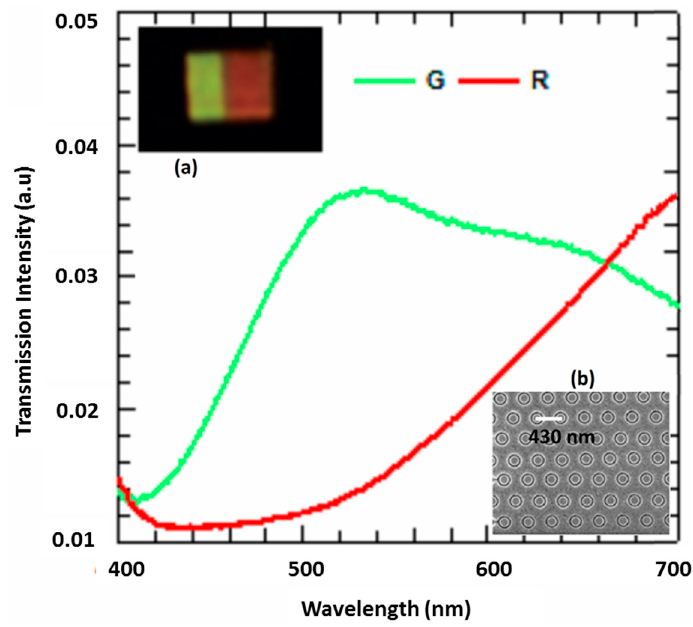
Figure 4. Experimentally measured transmission spectra of the green and red filters. The inset images show ( a ) optical image of the filters under an optical microscope (magnification 50 × ) and ( b ) SEM image of CH-based plasmonic filter.